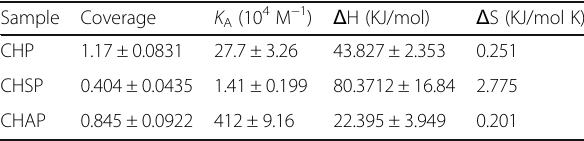
Table 2 Degree of coverage, affinity ( K A ), and enthalpy and entropy changes for binding with HSA titrated into NP solutions of different surface charge at 25 °C Sample